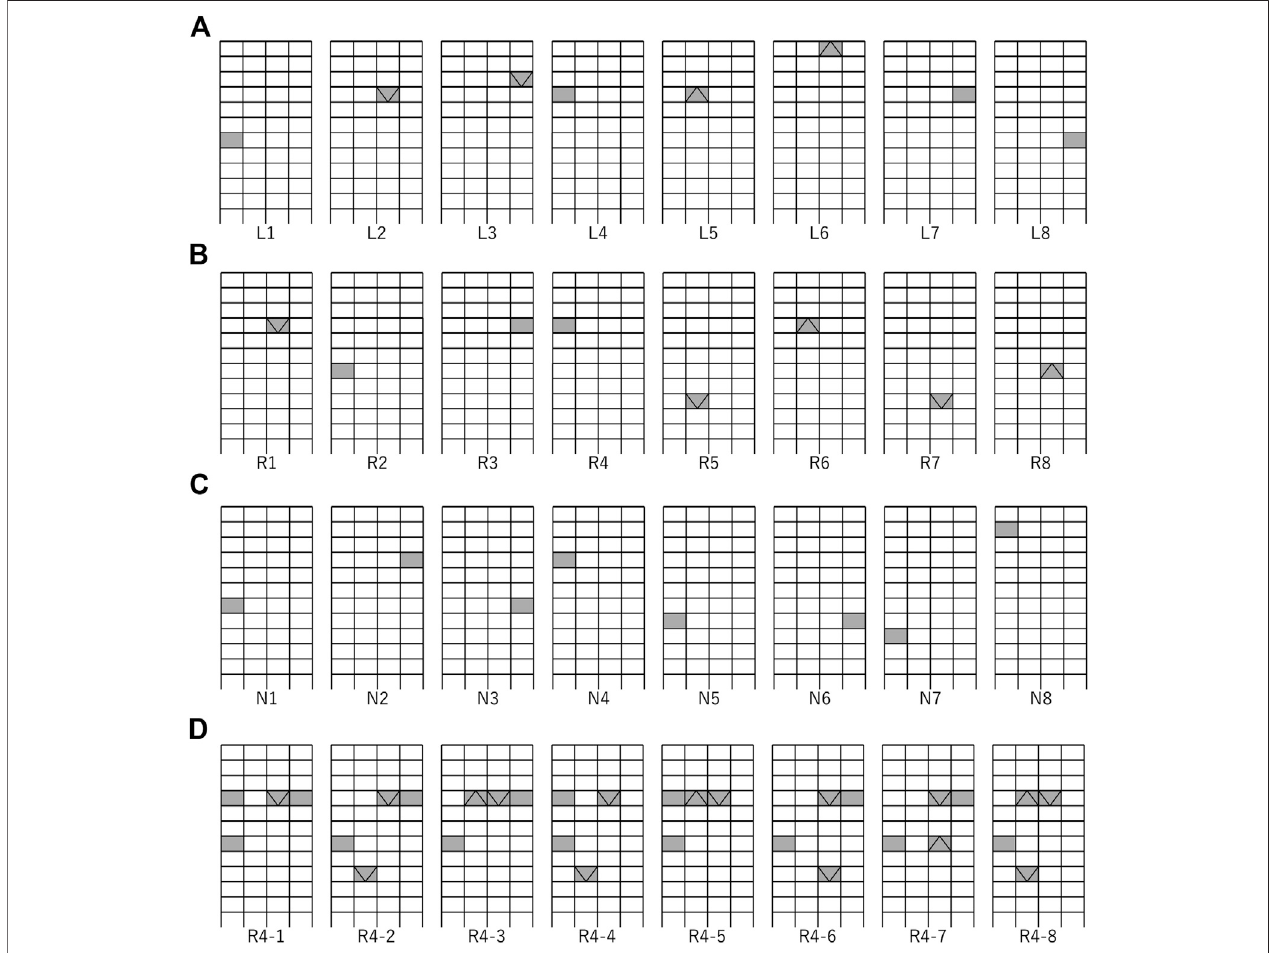
FIGURE 5 | Features with the eight largest contributions to approximate optimal solution; (A) linear kernel, (B) RBF kernel, (C) number of samples given as n good − n bad , (D) sets of four features using RBF kernel.